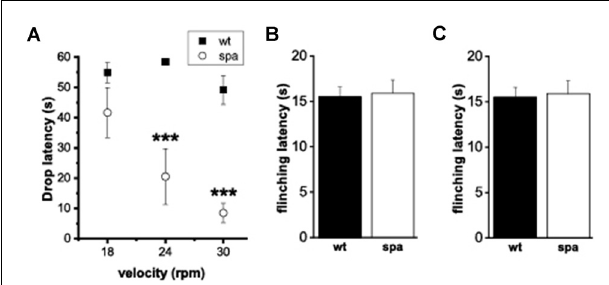
FIGURE 3 | Motor performance and pain-related behavior. (A) Rotarod-test; mean time on the Rotarod. Motor ability was decreased markedly in mutant mice. (B,C) Heat-sensitivity assays. (B) Tail-flick assay; mean tail flick latencies. (C) Hotplate assay; mean reaction latencies. No differences were observed between the genotypes (*** p < 0.001).